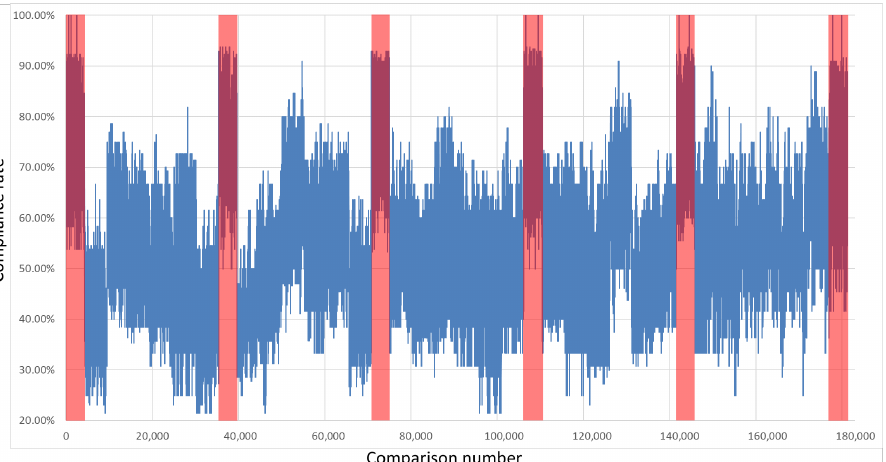
Figure 7. Results of the comparison of each key pair for all boards in a set—Xilinx Spartan 6 x 4 + x + 1.